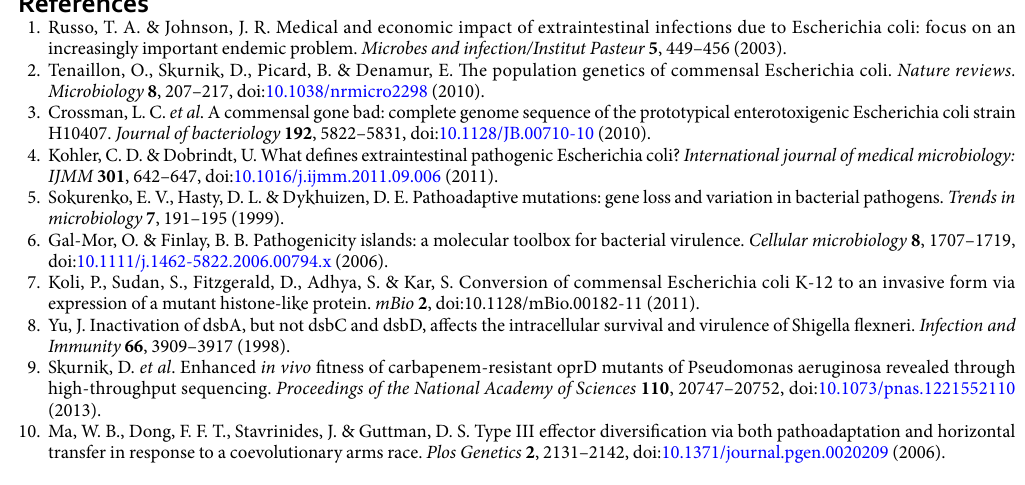
tingency table. For bacterial survival inside M Φ s a Mann-Whitney test was performed. For qPCR data, a t-test was performed on fold change values (log2). E . coli expression arrays data was analysed in R software (R core team 2015) library Limma 65 using an empirical Bayes paired test. M Φ expression arrays of Anc vs . M6 infected M Φ were analysed in R software (R core team 2015) library Limma 65 using an empirical Bayes paired test. M Φ expres- sion array data comparing infected vs . uninfected cells was performed with chipster software 66 using empirical bayes statistical test. Padjusted values were calculated using Benjamin Hocheberg FDR